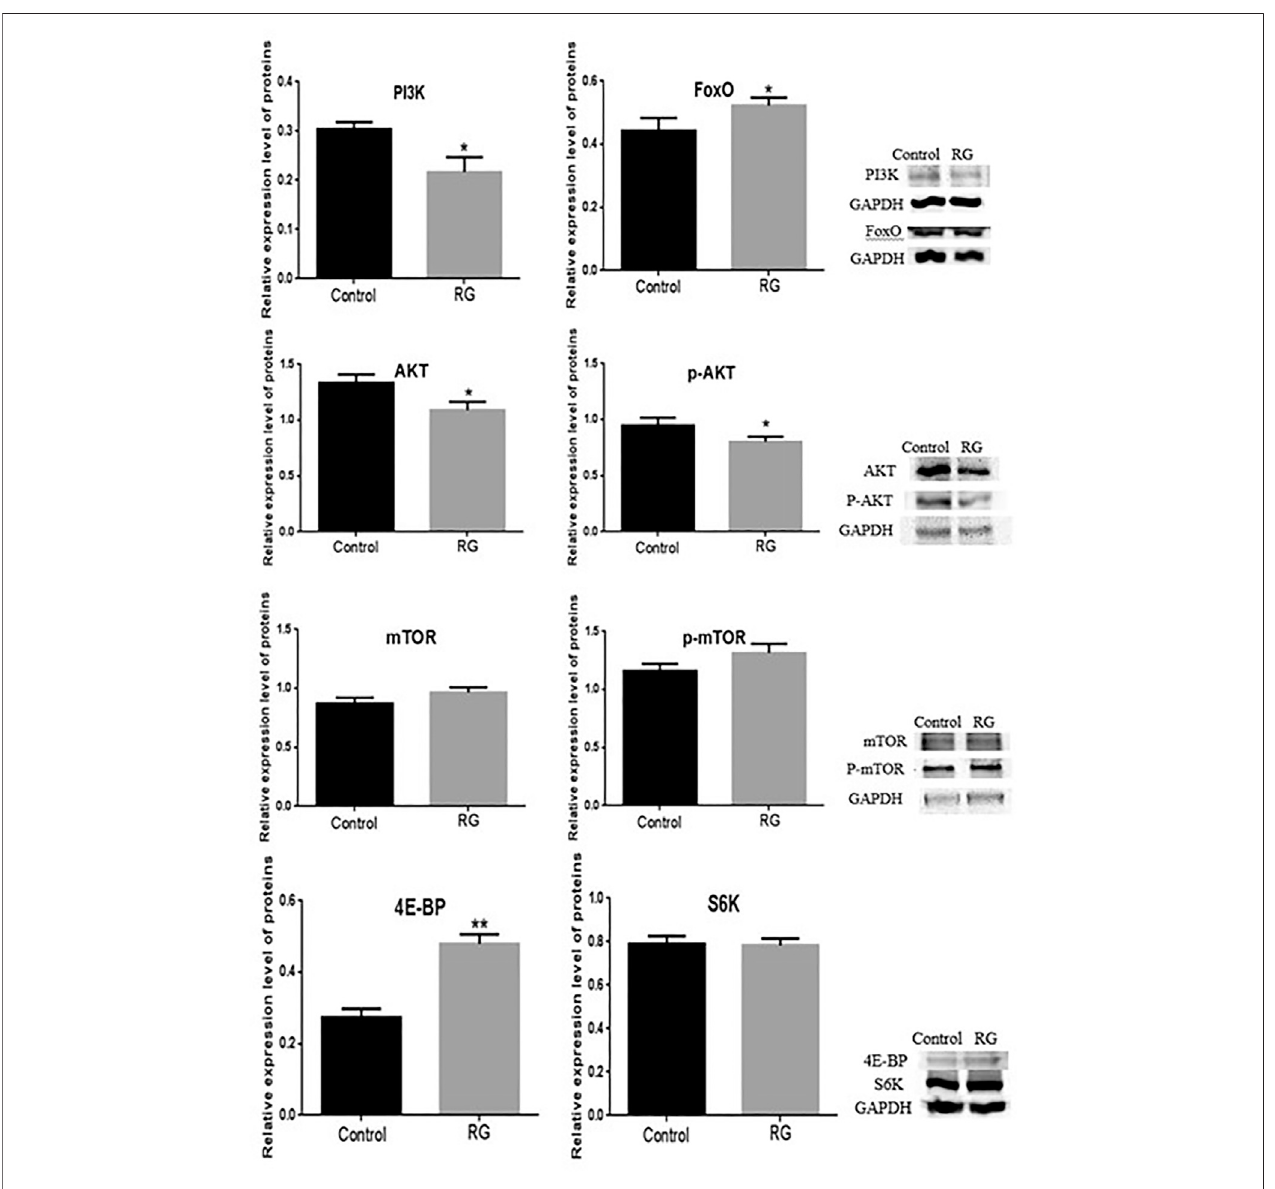
FIGURE 7 | Expression of PI3K, AKT, p-AKT, mTOR, p-mTOR, 4E-BP, S6K and FoxO were con fi rmed using western blotting. P value < 0.05 was considered statisticallysigni fi cant.;Abbreviation:RG,redginseng;Con,control;AKT,proteinkinaseB;mTOR,mechanistictargetofrapamycin,PI3K,phosphatidylinositol3kinase; 4E-BP, eukaryotic translation initiation factor 4E binding protein; S6K, S6 protein kinase; FoxO, forkhead box O.